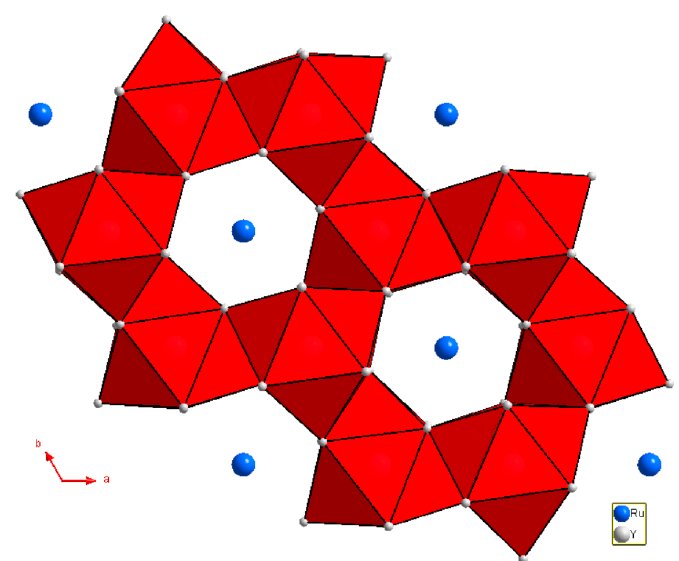
Figure 2. The structure of Y 3 Ru 2 − x may be described as constructed from Ru-centred tri-capped trigonal prisms of Y (RuY 9 ). These entities share faces along the c-axis and edges in the perpendicular direction so that each Y atom is shared between three RuY 9 polyhedra yielding a structure in the first sub cell with the composition RuY 3 . The Ru atom in the second sub cell (Ru2, blue) resides in the trigonal antiprismatic tunnels formed by the first sub structure.